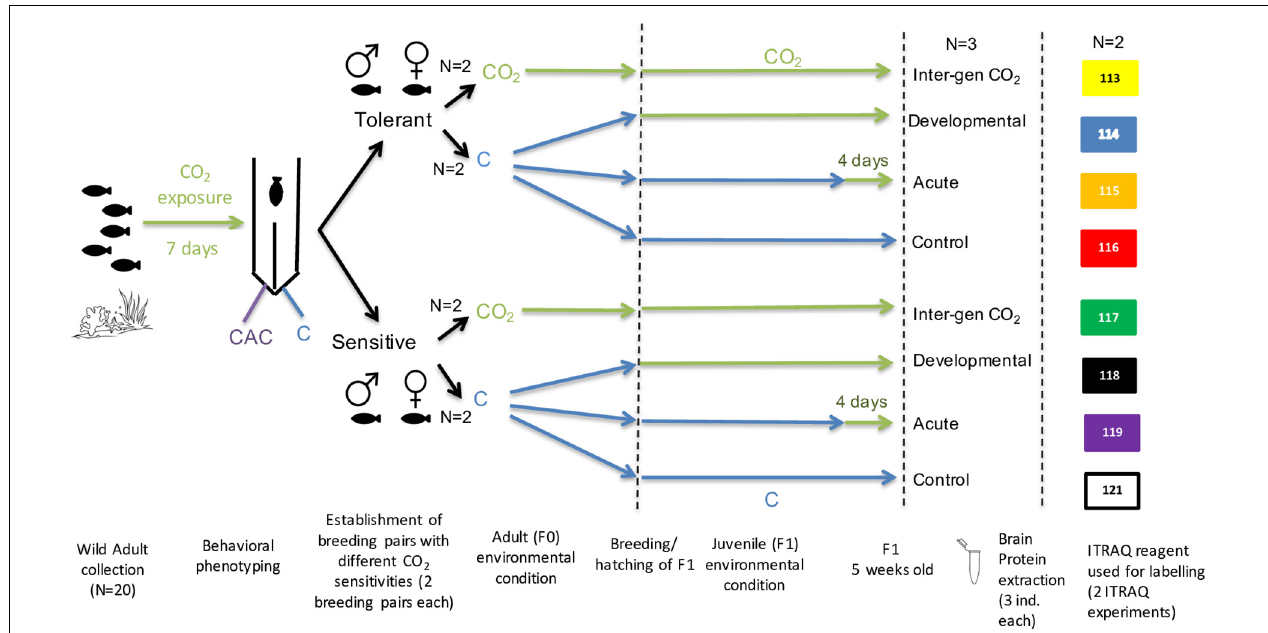
FIGURE 1 | Schematic of experimental design from wild adult fish collection, behavioural testing, environmental CO2 exposure treatments and Proteome iTraq experimental design.